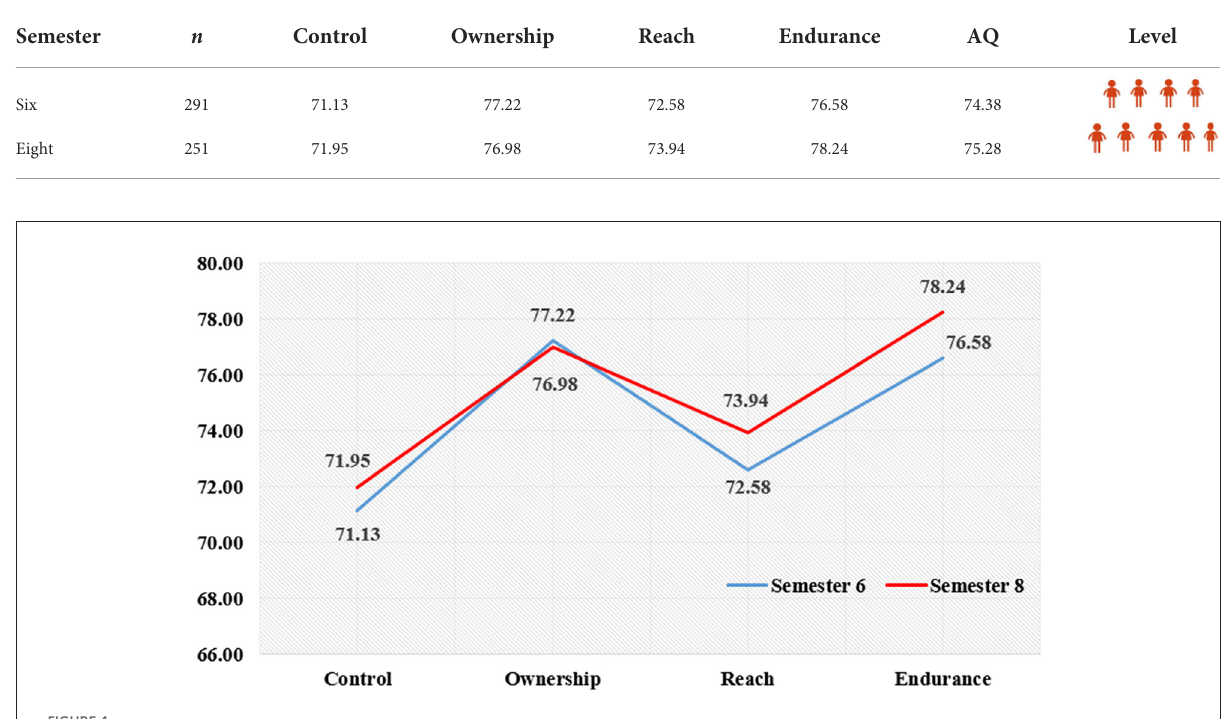
FIGURE4 AQ index by construct based on semester of